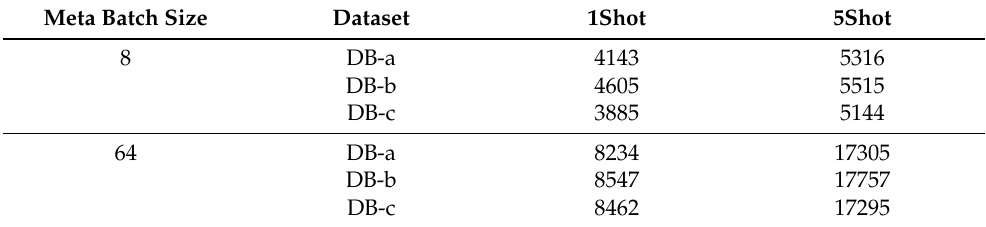
Table 9. 5-way 1-shot and 5-way 5-shot classification training time (ms) with different meta batch size on new subject on CapgMyo by CSAC-Net with MAML.